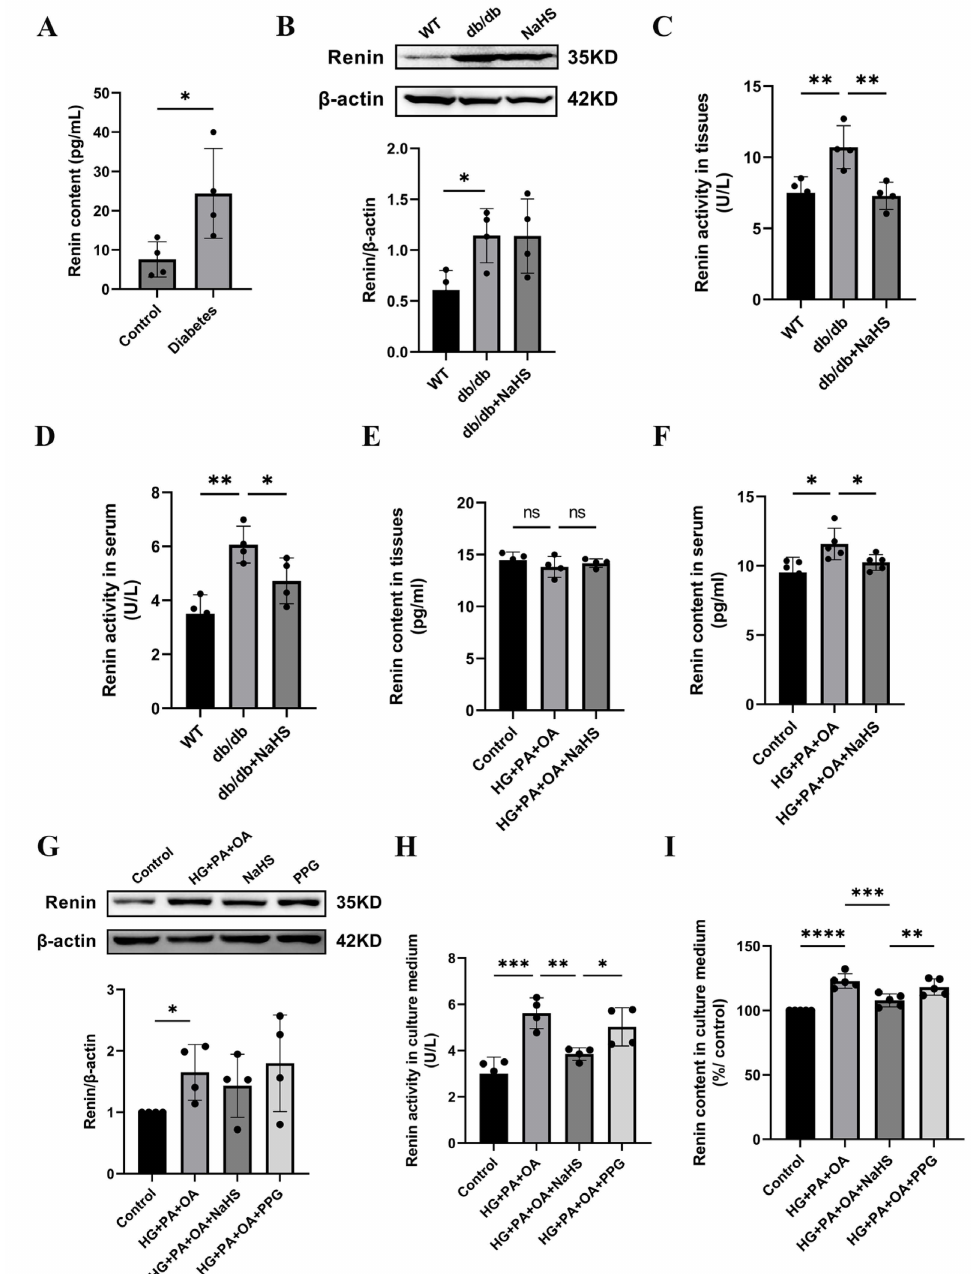
Figure 3. Effect of exogenous H 2 S on renin expression, renin activity and renin release. ( A ) Renin content in the serum of normoglycemic patients and patients with diabetes and hypertension ( n = 4). ( B ) Renin expression level in kidney tissues of db/db mice was detected by Western blotting ( n = 4). Renin activity and content in the serum and kidney tissues ( C – F ) and culture medium of JG cells ( H , I ) detected by ELISA kits ( n = 4–5). ( G ) Western blot analysis of renin in JG cells ( n = 4). * p < 0.05, ** p < 0.01, *** p < 0.001, **** p <